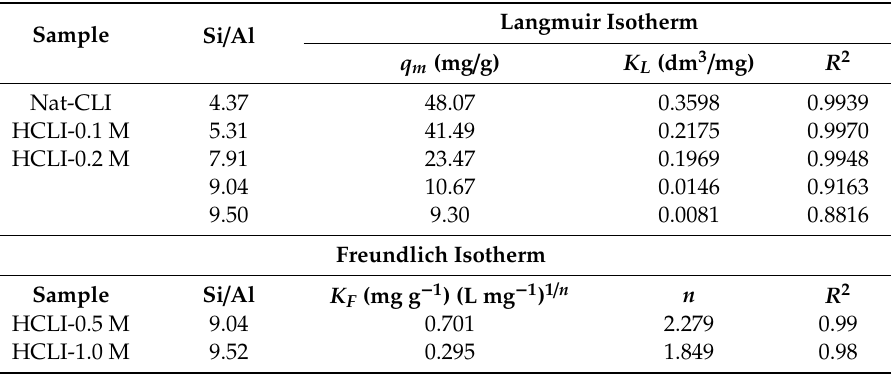
Table 3. Description of Pb(II) sorption by Nat-CLI and H-CLI from the parameters obtained applying the Langmuir and Freundlich